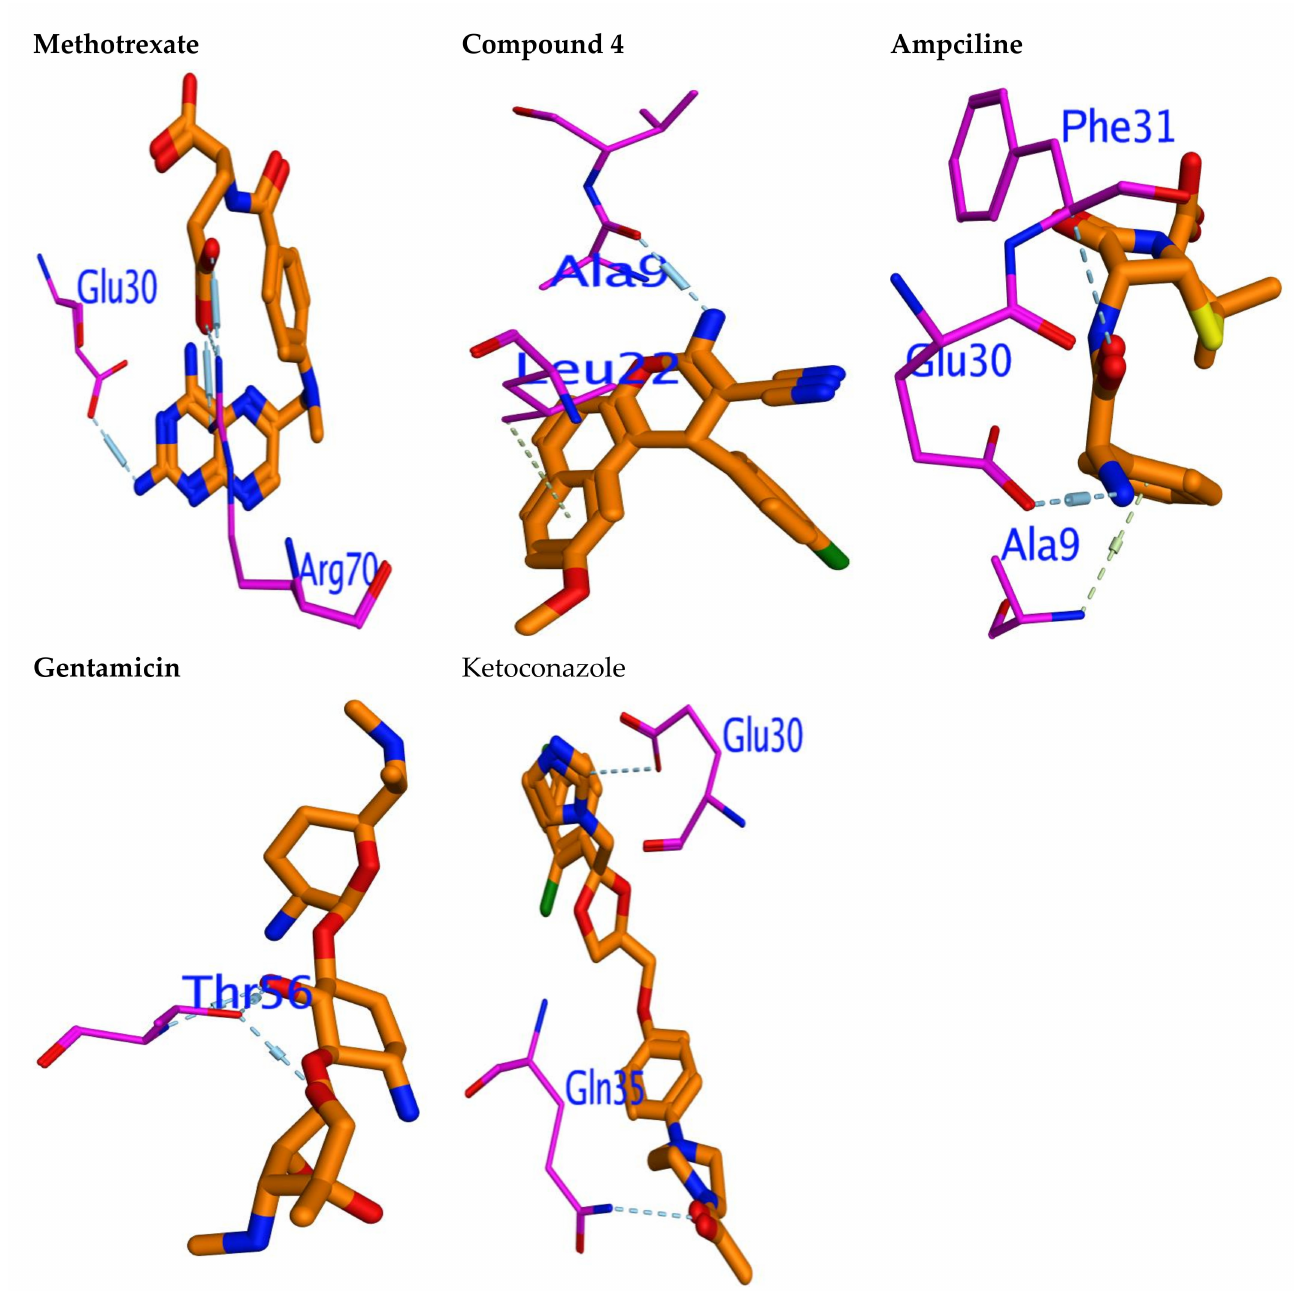
Figure 4. Predicted binding mode of compounds 4 and reference inhibitors into 3NTZ H-bondings represented in blue lines, while π - π bond in green